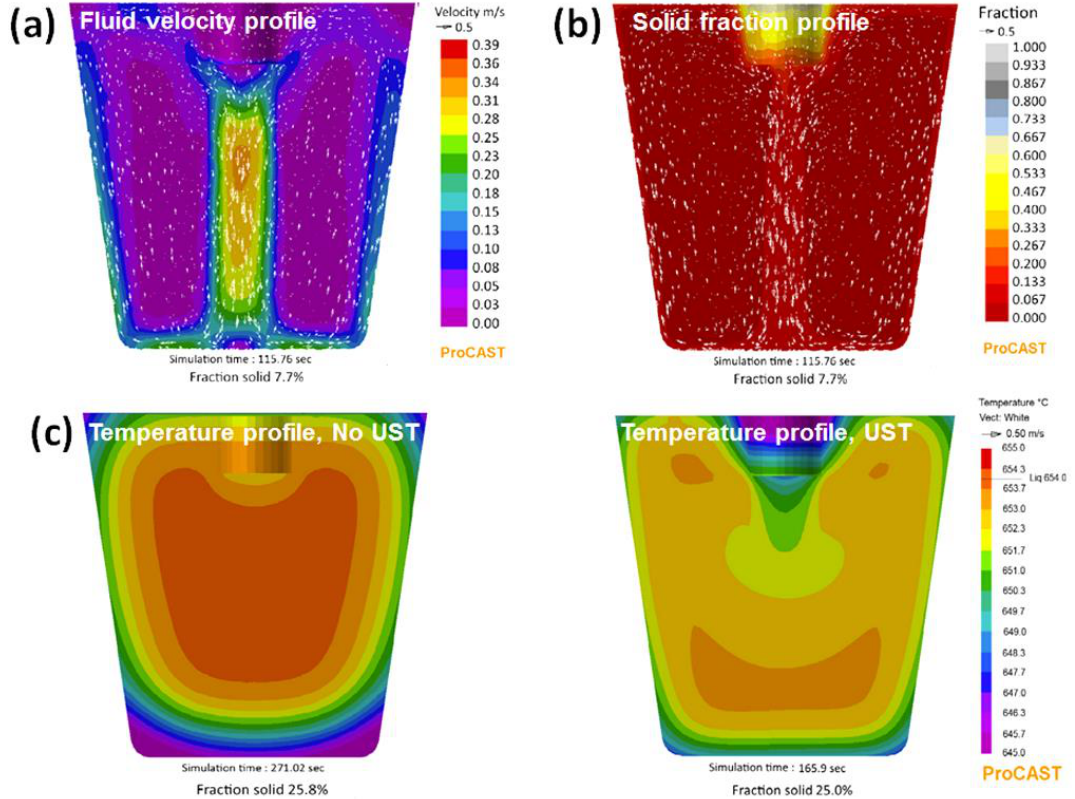
Figure 3. Simulations of ( a ) Fluid velocity and ( b ) solid fraction during UST, and ( c ) temperature gradient before and after UST in Al–2Cu alloy [38].